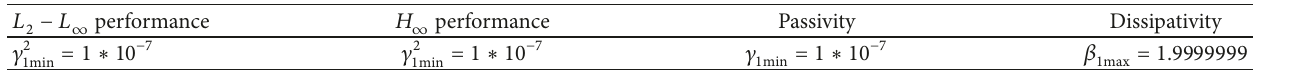
Table 2: Optimized variable for each case.